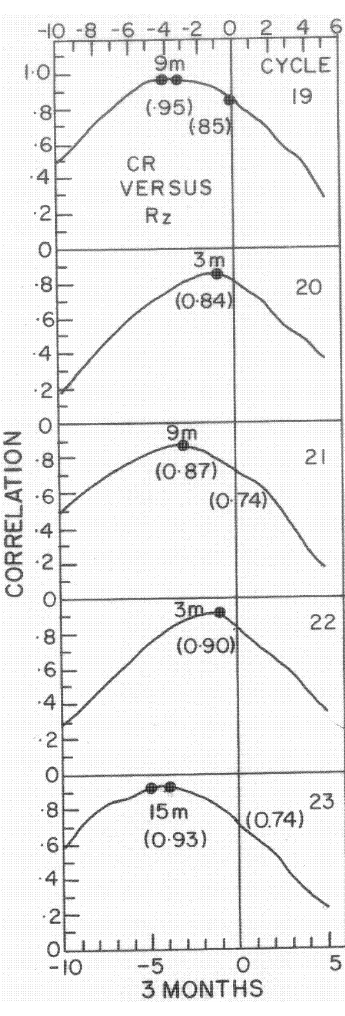
Fig. 3. Cross-correlation between CR and Rz for cycles 19–23. Ab- scissa shows phase difference in 3-month units.